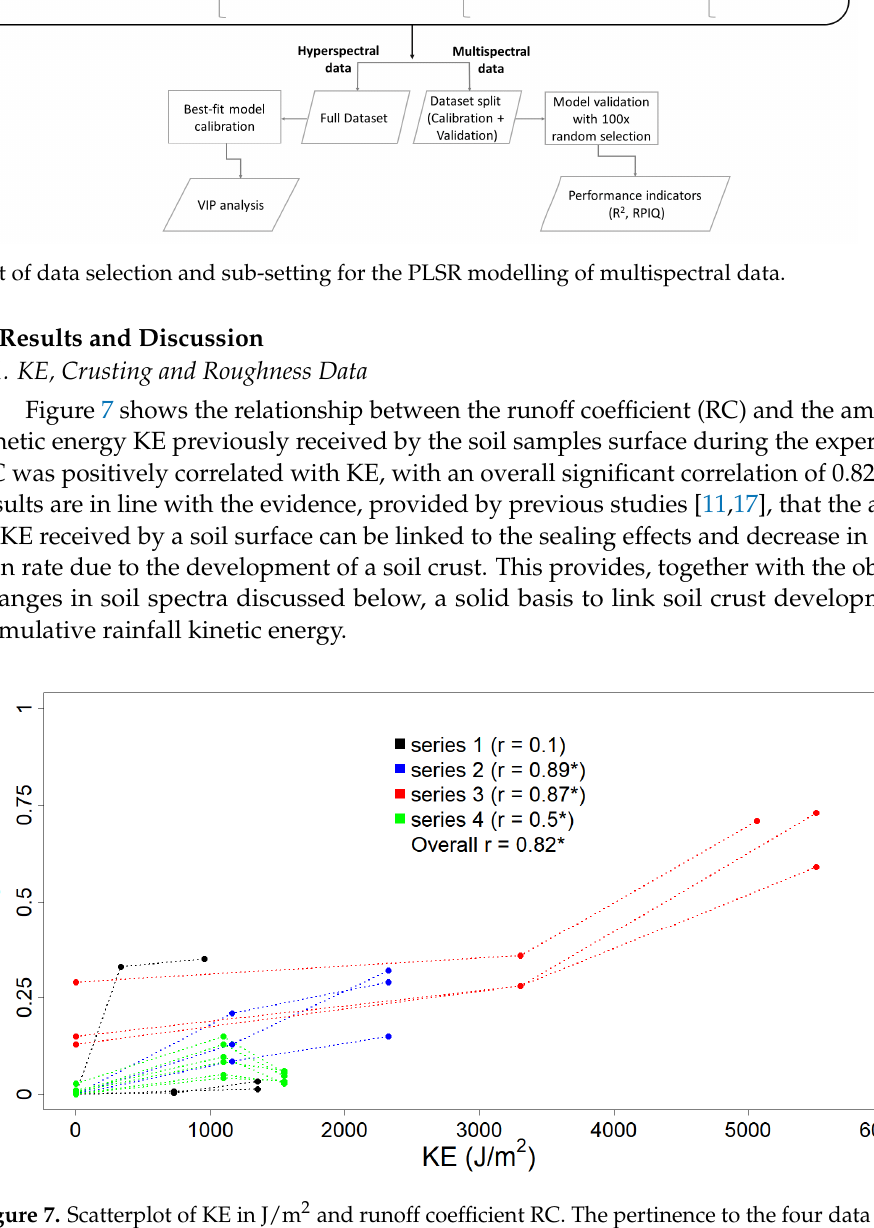
Figure 6. Flowchart of data selection and sub-setting for the PLSR modelling of multispectral data.